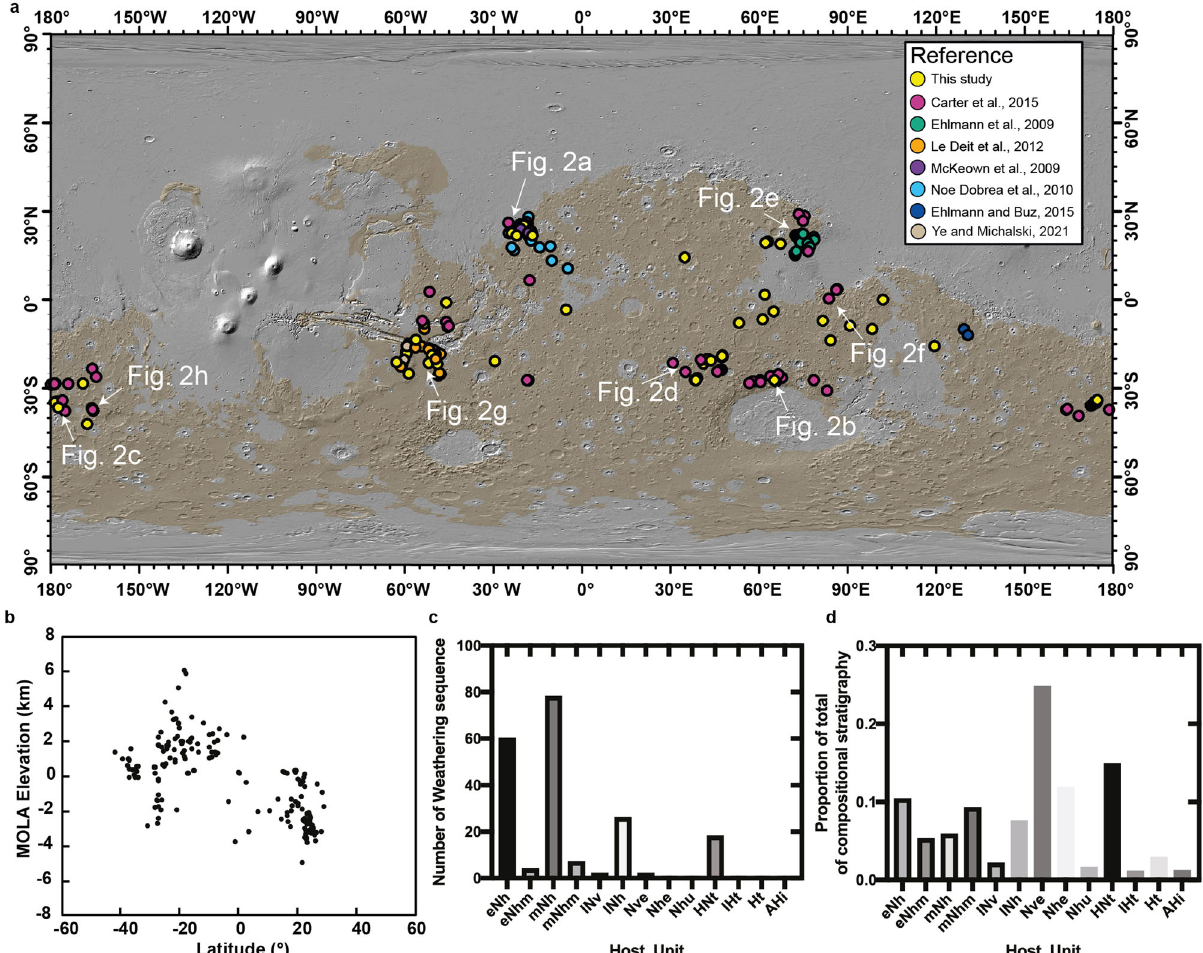
Fig. 1 Compositional stratigraphy deposits on Mars, consisting of Al/Si materials and Fe/Mg smectites. a This global map shows the locations of 203 outcrops of compositional stratigraphy on Mars including those compiled from previous studies and 54 new detections presented in this work (Supplementary Table 1). The different colors indicate 203 exposures of compositional stratigraphy compiled from the previous studies 14,15,19 – 41 and 54 additional new detections in this contribution (Supplementary Table 1). The based map is Mars Orbiter Laser Altimeter hillshade data (gray) drapped by Noachian geology units (brown) 45 . b Analysis of the latitude and MOLA elevation of 203 compositional exposures show a wide range of elevations and con fi ned latitudes of these deposits. c A histogram of the host unit for compositional stratigraphy shows the range of host geology units 45 . d A histogram of the host unit of weathering sequences after area